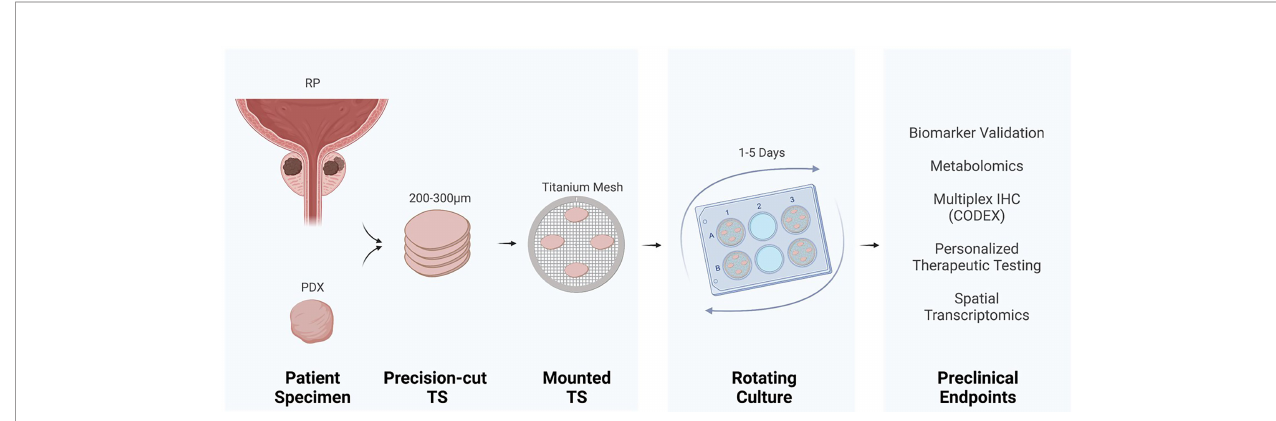
FIGURE 1 | Tissue slice culture work fl ow and preclinical endpoints. Precision cut tissue slices (TS) derived from radical prostatectomy (RP) or a patient-derived xenograft (PDX) incubate on titanium mesh grids at a 45° angle within a rotating tissue culture